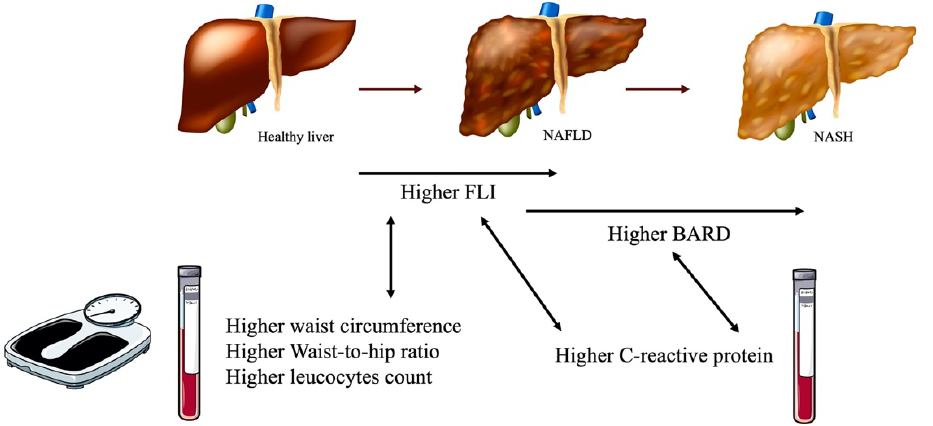
Figure 2. Schematic representation of our main results. Abbreviations: NAFLD, non-alcoholic fatty liver disease; NASH, non-alcoholic steatohepatitis; FLI, Fatty Liver Index; BARD, BMI, AST/ALT ratio, and presence of diabetes. Parts of the figure were adapted with permission from von-Hafe and Borges-Canha et al. [19], and parts were drawn by using pictures from Servier Medical Art (licensed under a Creative Commons Attribution 3.0 Unported License; https://creativecommons.org/licenses/by/3.0/, accessed on 28 June 2022).